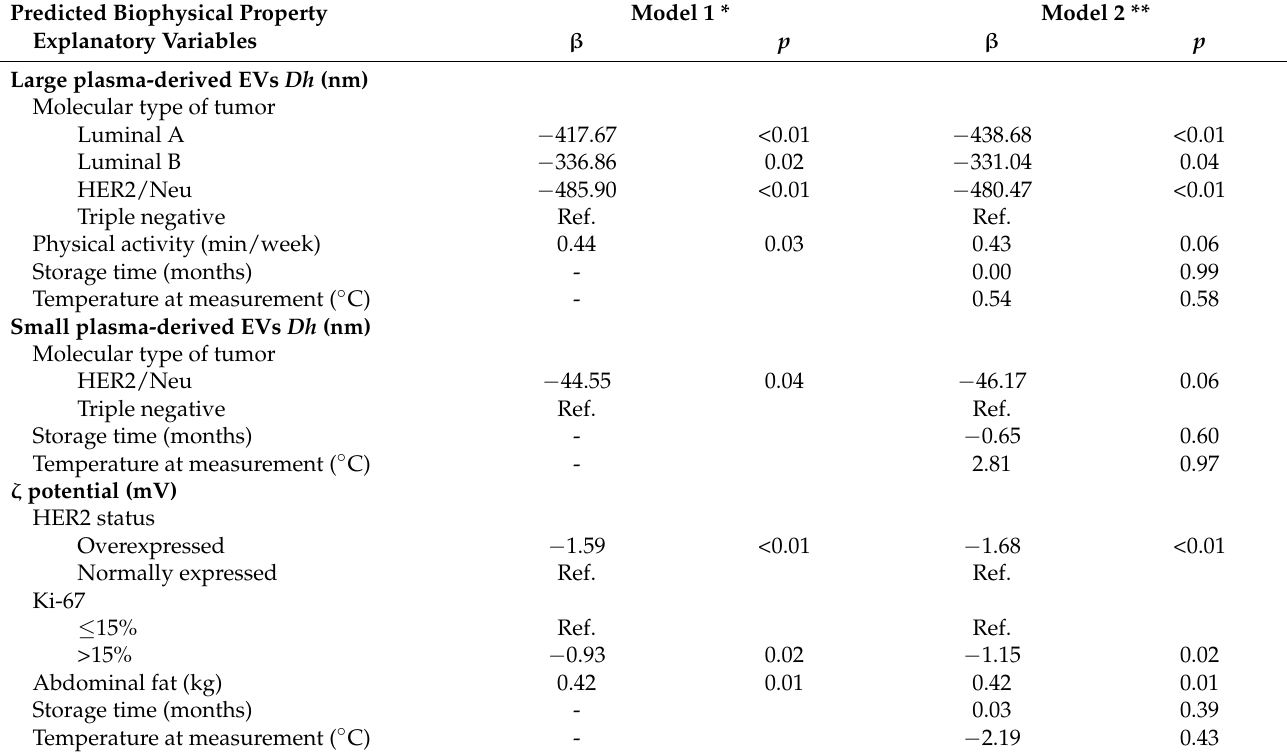
Table 4. Mixed-effect linear regression models for prediction of biophysical properties of plasma- derived extracellular vesicles in breast cancer patients receiving an individualized nutrition interven- tion during the first six months of antineoplastic